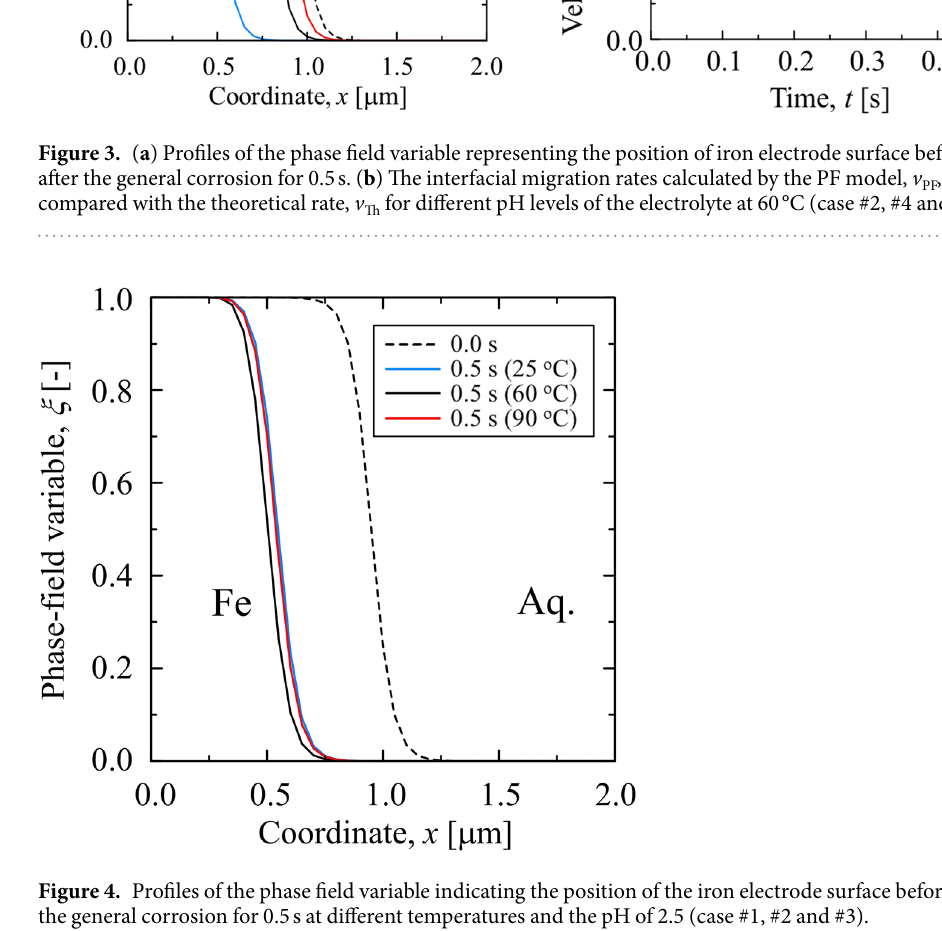
As shown in Fig. 3(b), the calculated v PF indicates a good agreement with v Th for all pH values. In order to further demonstrate that the proposed PF model can capture the effect of temperature on the corrosion rate, Fig. 4 shows the profiles of the phase field variable indicating the position of the electrode surface after 0.5 s at different temperatures (Case #1, #2 and #3) at the pH of 2.5. It is clearly observed that the corrosion rate slightly increases when the temperature increases, thereby indicating that the impact of temperature on the general corrosion rate is minor when compared with that of the pH of the electrolyte.